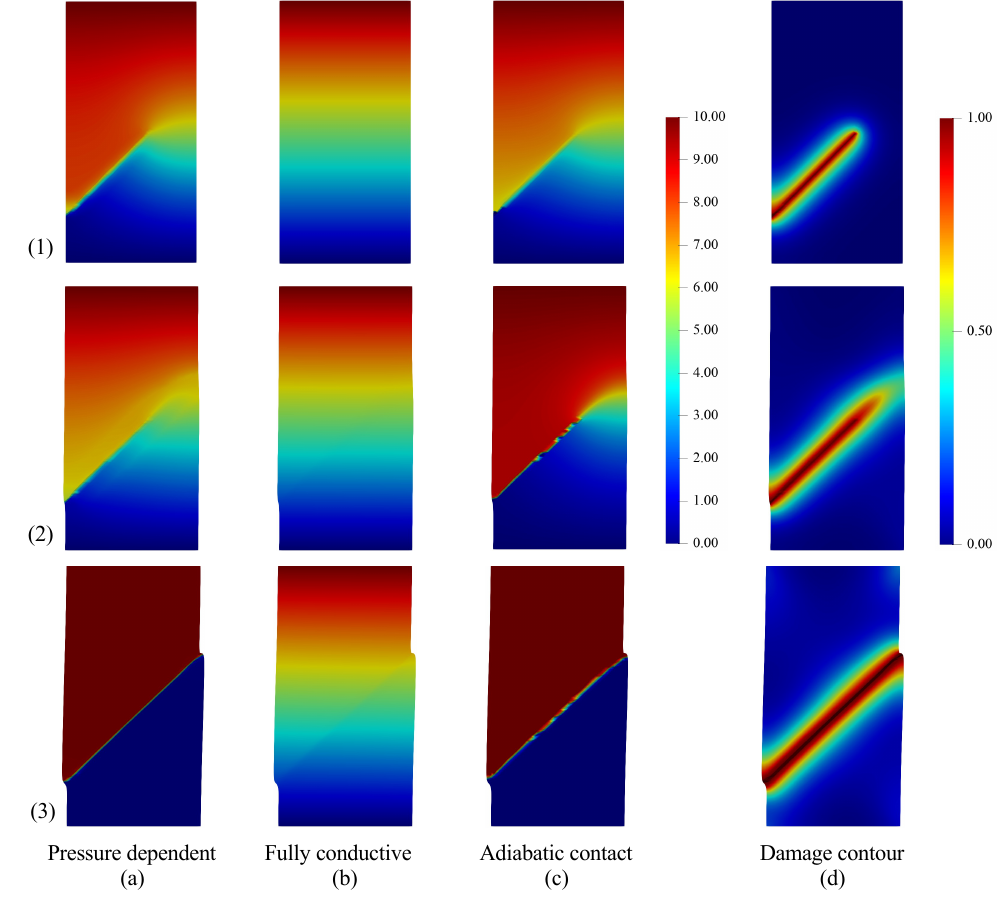
Figure 14. Temperature evolution in three different thermal models: ( a ) PDM, ( b ) FCM, and ( c ) ADM, with ( d ) damage contours at three load steps: (1) ˆ u y = − 2 × 10 − 4 m, (2) ˆ u y = − 1 × 10 − 2 m, and (3) ˆ u y = − 2 × 10 − 2